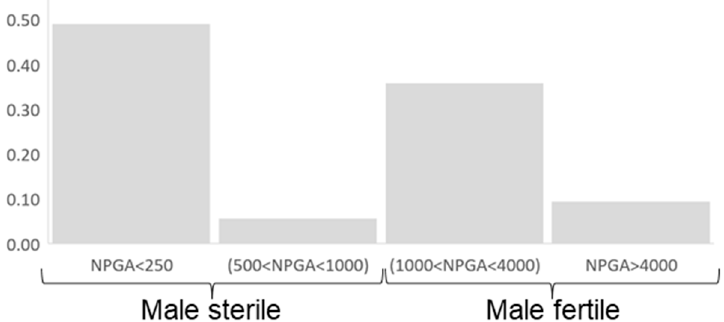
Figure 2. Histogram displaying the number of pollen grains per anther (NPGA) distribution in the diploid hybrids analyzed.